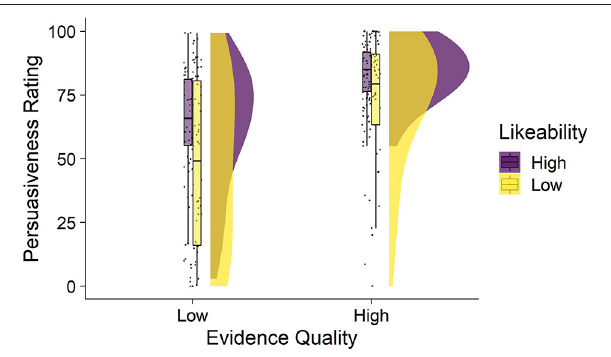
FIGURE 1 | Persuasiveness as a function of expert evidence quality and likeability (Study 1). Figure depicts four raincloud plots showing the distribution of persuasiveness ratings observed in each condition. From left to right, each raincloud plot shows the: jittered individual data points, box-and-whisker plots (middle bar within the box is the median, the box represents the interquartile range of persuasiveness ratings, and the whiskers represent persuasiveness ratings no further than 1.5 × the interquartile range), and the distributions showing the frequency of persuasiveness ratings. Mean persuasiveness ratings differed by evidence quality and likeability